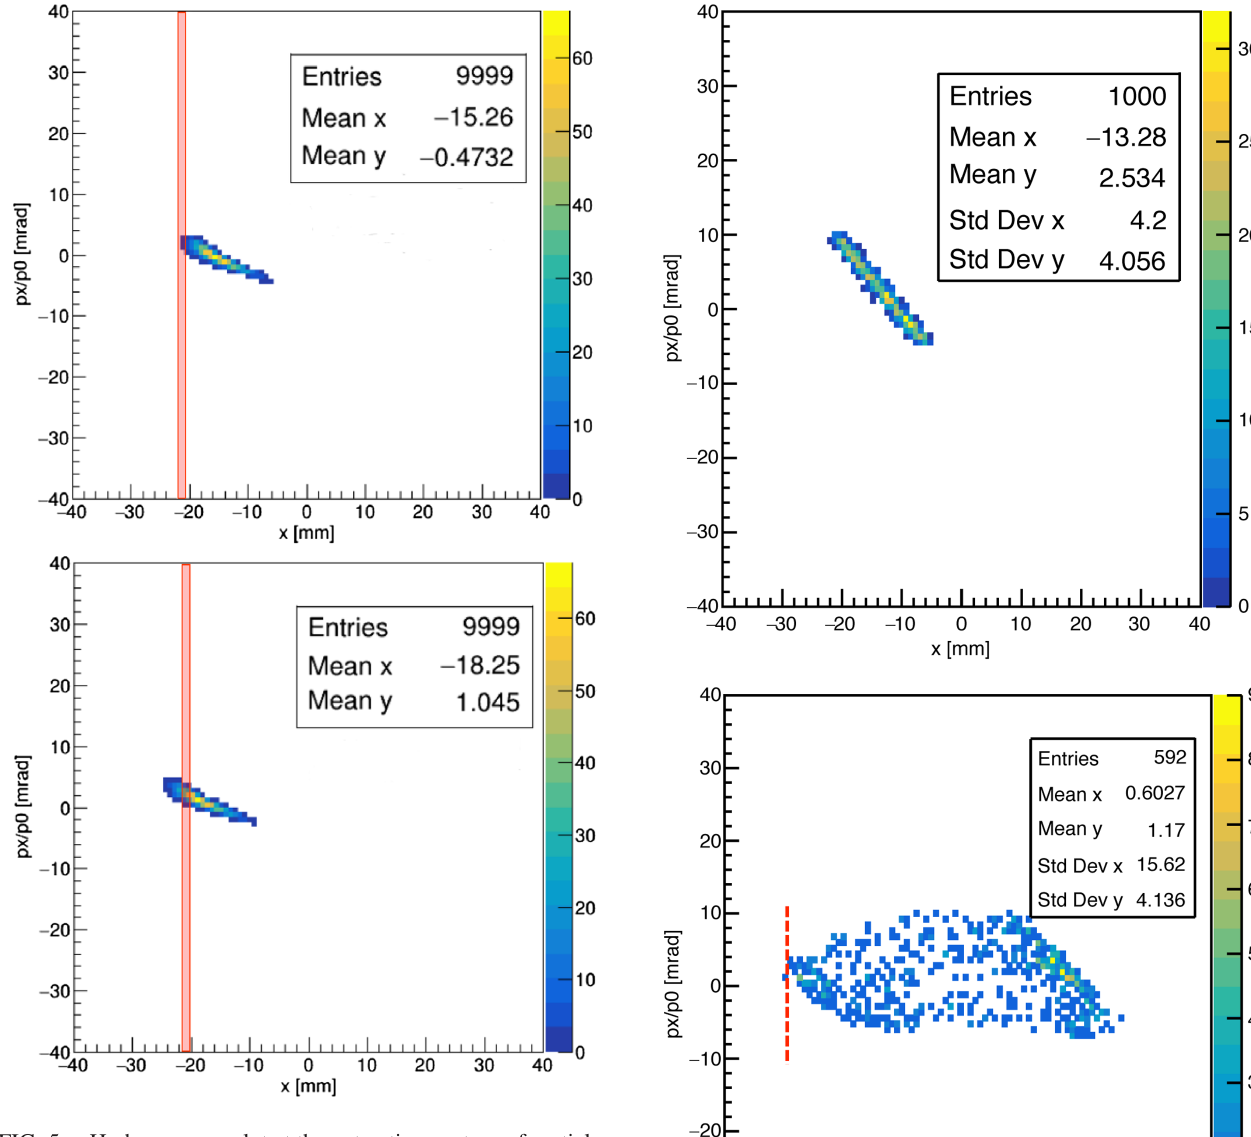
FIG. 5. H phase space plot at the extraction septum of particles injected with a +10 mm offset from beam pipe center and tracked for 1 turn. Top: particles do not receive a kick by the crystal. Bottom: particles receive a 1 mrad kick by the crystal. Particles close to the septum are moved out of it, in the extraction channel.